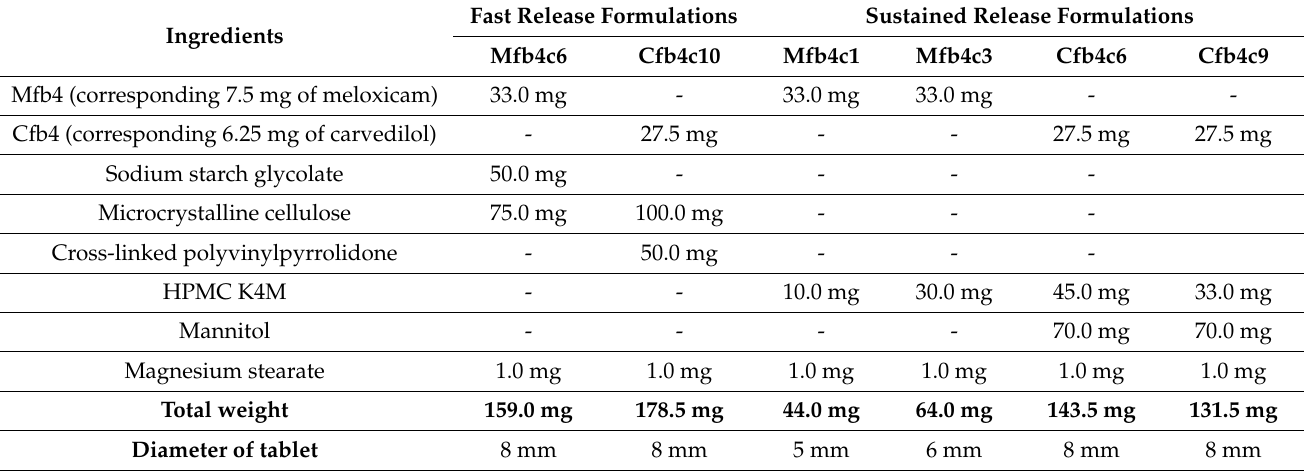
Table 2. Single unit composition of the fast release formulations / sustained release formulations containing fibers and diameter of the tablet